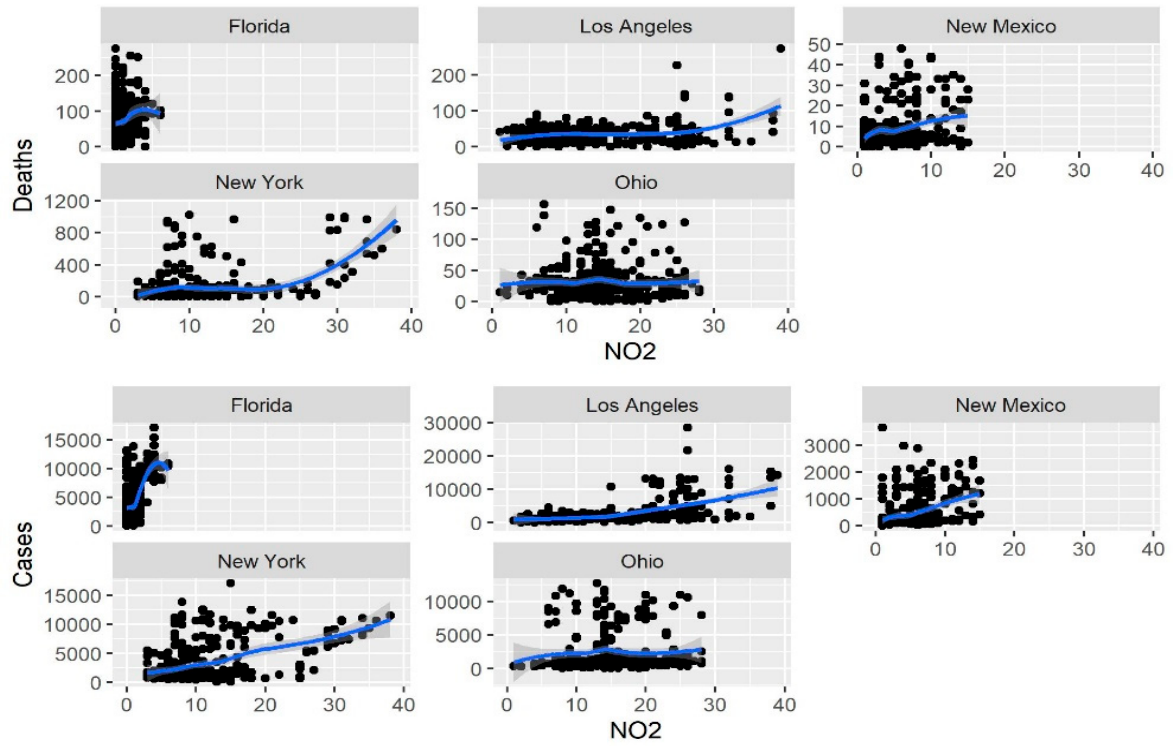
Figure 7. Relationship of the NO 2 concentration with the number of new daily cases and deaths.